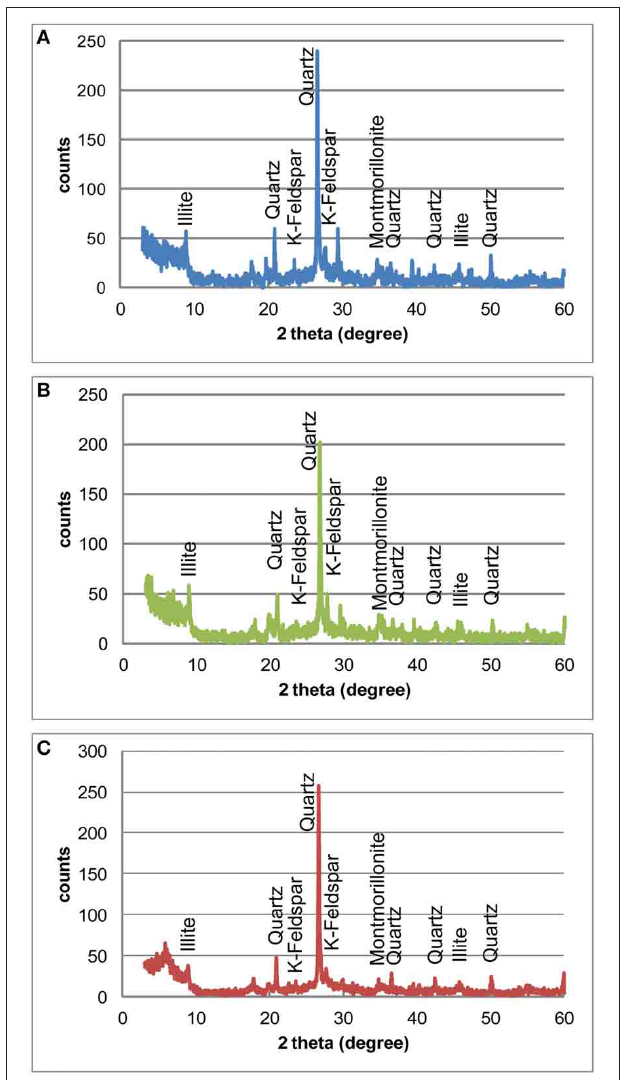
FIGURE 8 | Results (diffractograms) from X-ray diffraction (XRD) analyses. (A) Diffractogram from the analysis on clayey residual material from pressure solution seams occurring at the carbonate-chert interface (e.g., Figure 7B ). (B) Diffractogram from the analysis on clayey residual material from fault surfaces with slickolites (e.g., Figure 7E ). (C) Diffractogram from the analysis on clayey residual material obtained after laboratory total dissolution of a carbonate sample (Scaglia Bianca Fm.) in an acidic solution (water-diluted HCl).